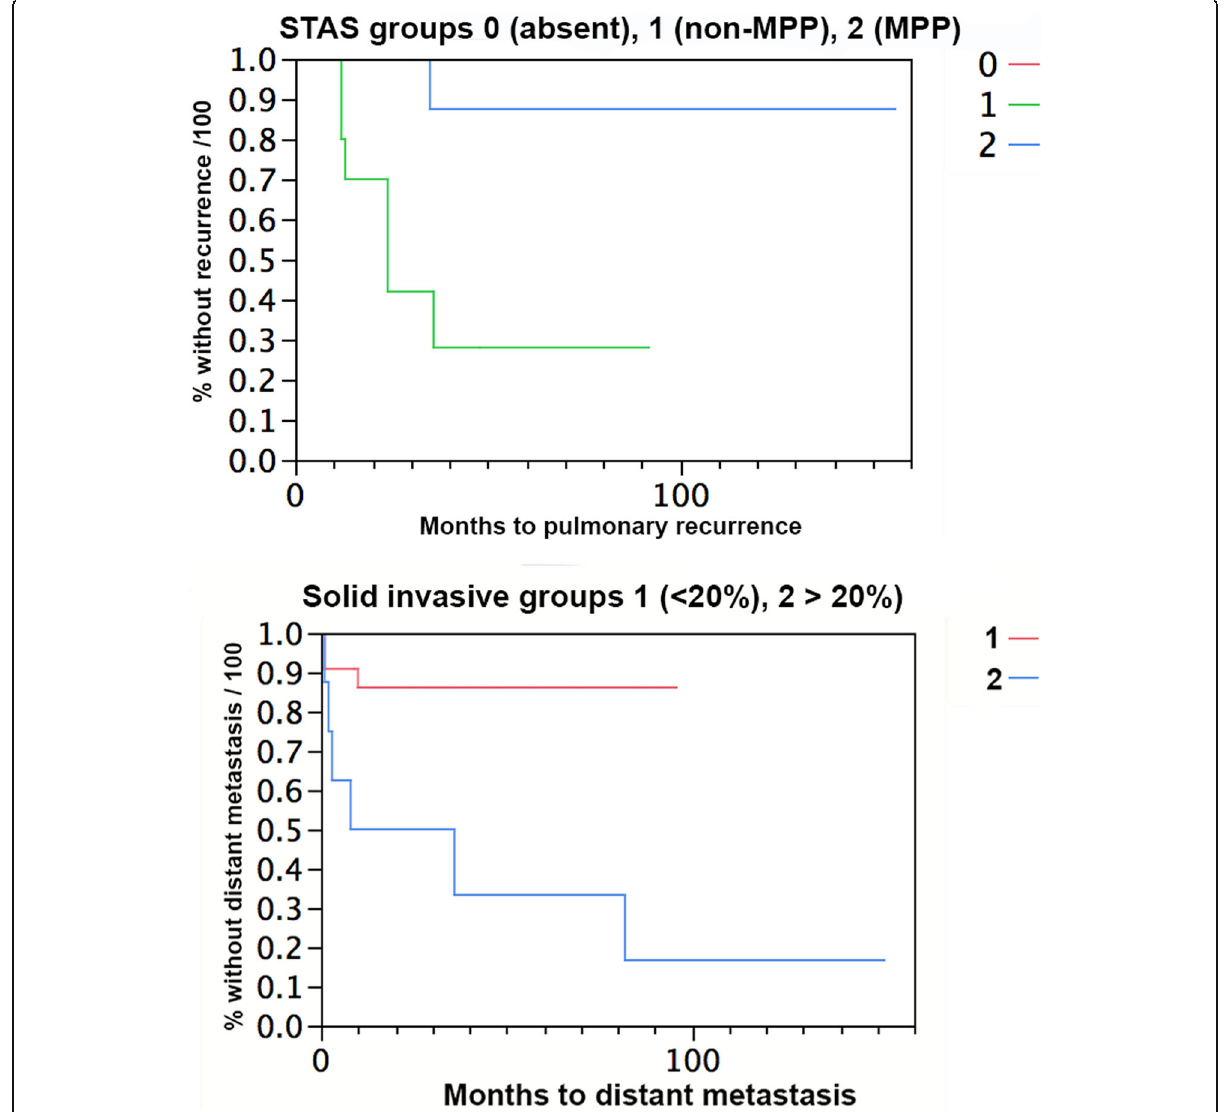
Fig. 5 Time-adjusted Kaplan Meier curves relating STAS to local recurrence (top) and proportion of solid growth to distant recurrence (bottom). There was a significant increase in the rate of local recurrence by STAS ( p = .005) and in the rate of distant recurrence by solid invasive group ( p =